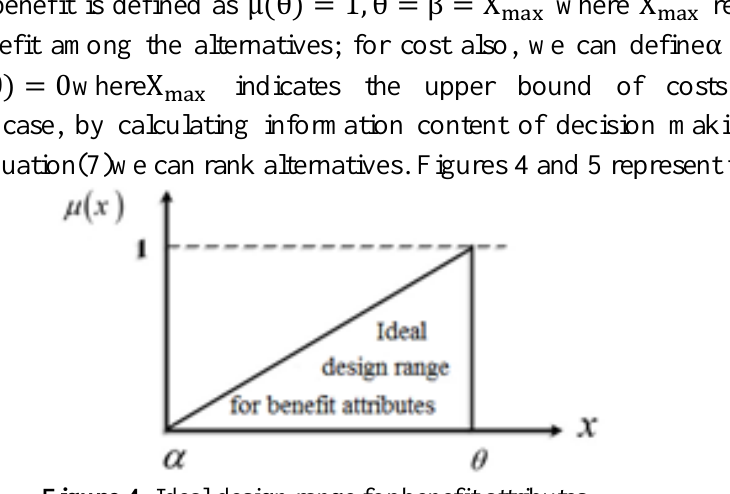
indicates the upper bound of costs related to